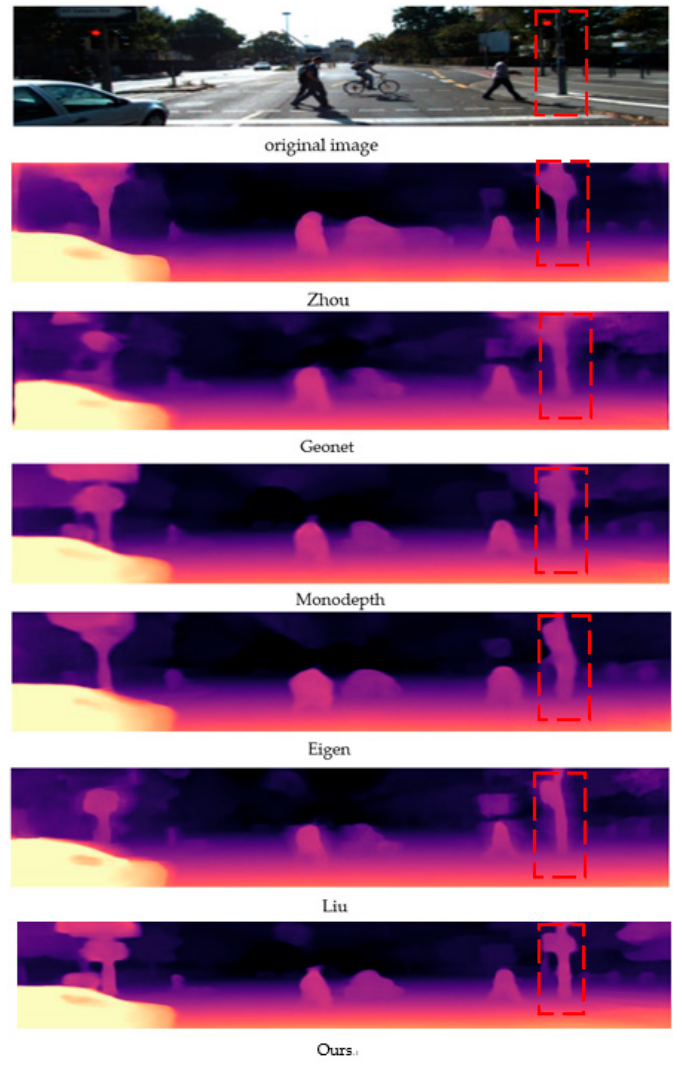
Figure 3. Comparison with current mainstream algorithms. The red dotted frame shows that the algorithm in this paper does not have pixels pulled around the relatively moving objects.